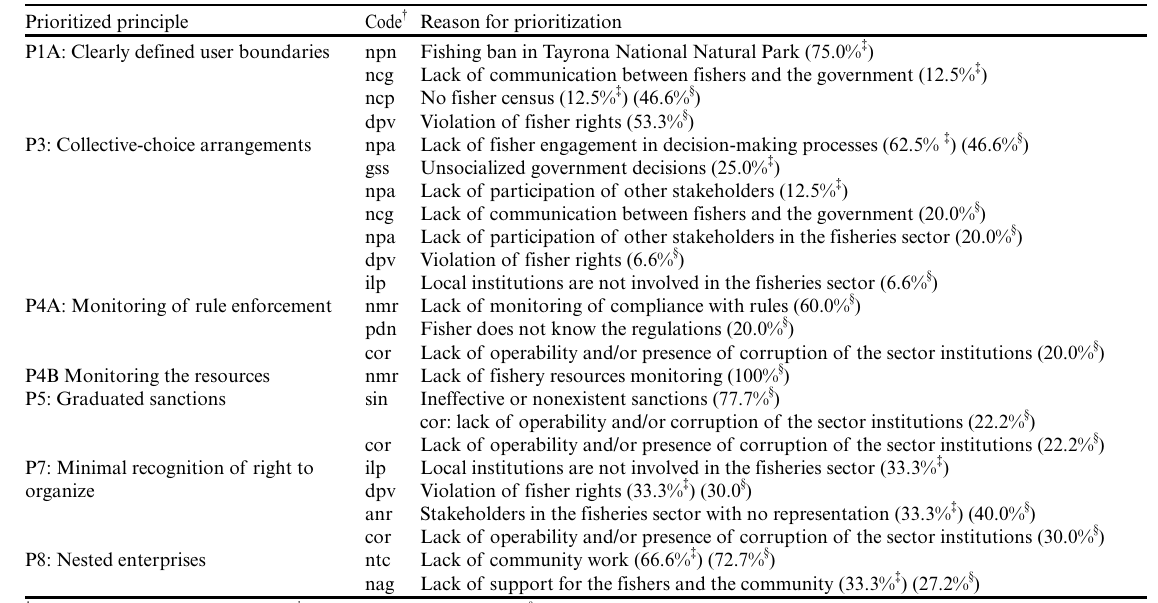
Table 5. Fishers’ reasons for prioritizing Ostrom’s design principles (Ostrom 1990, Cox et al. 2010) in two small-scale marine fishing communities in Colombia.